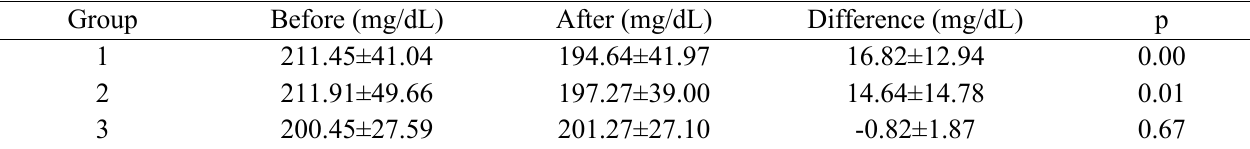
Table 2. Mean of total cholesterol distribution before and after intervention Group Before (mg/dL) After